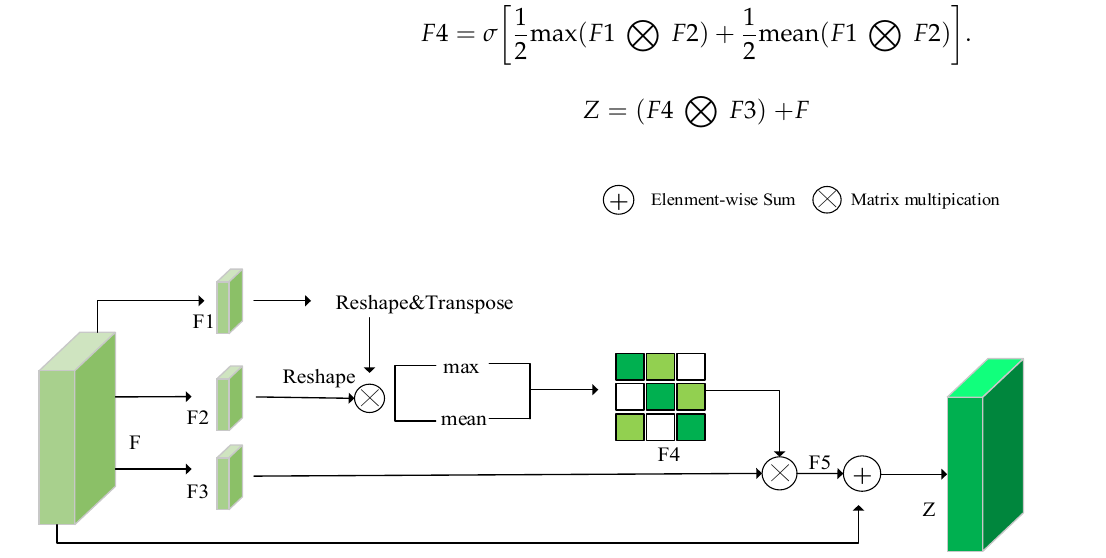
Figure 5. Position attention block.